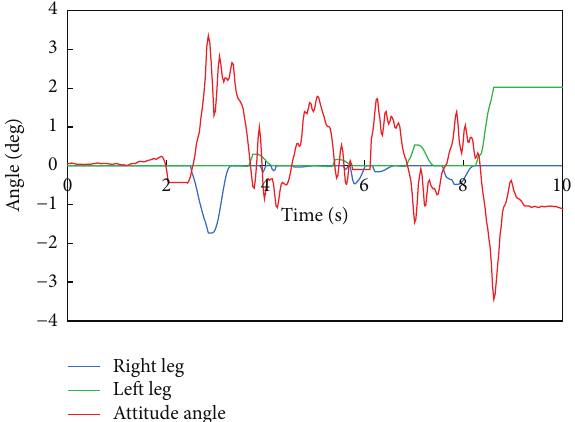
Figure 14: Waking experiments with the human-like foot mech- anism. The walking cycle is 1.0 s/step and the step length is 450